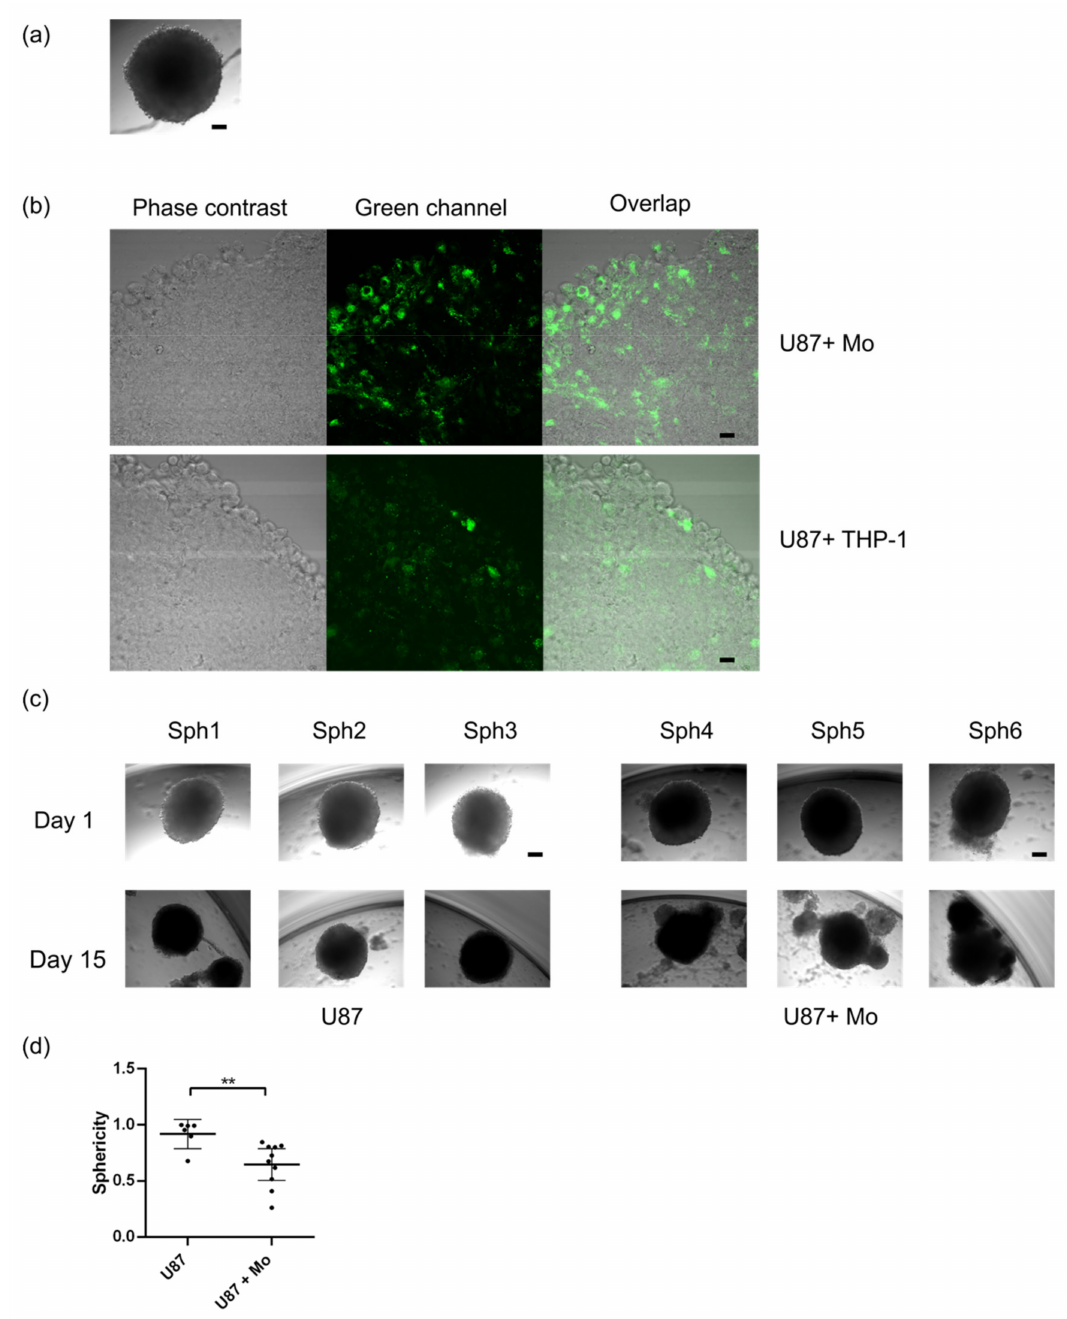
Figure 3. Impact of primary human monocytes on the growth of U87MG spheroids. ( a ) The appearance of 7 day-hanging drop spheroid generated from U87MG cells. ( b ) Phase contrast and confocal images of spheroids infiltrated with primary human monocytes (Mo) and THP-1 cells (in green) after 5 days of co-culture. ( c ) Representative images of U87MG spheroids at days 1 and 15 after infiltration with primary human monocytes showing loss of sphericity in the co-culture conditions. ( d ) Independent data showing loss of sphericity in spheroids without ( n = 6) and with ( n = 9) primary human monocytes. A two-tailed unpaired t -test was performed **: p ≤ 0.01. Scale bar: 50 µ